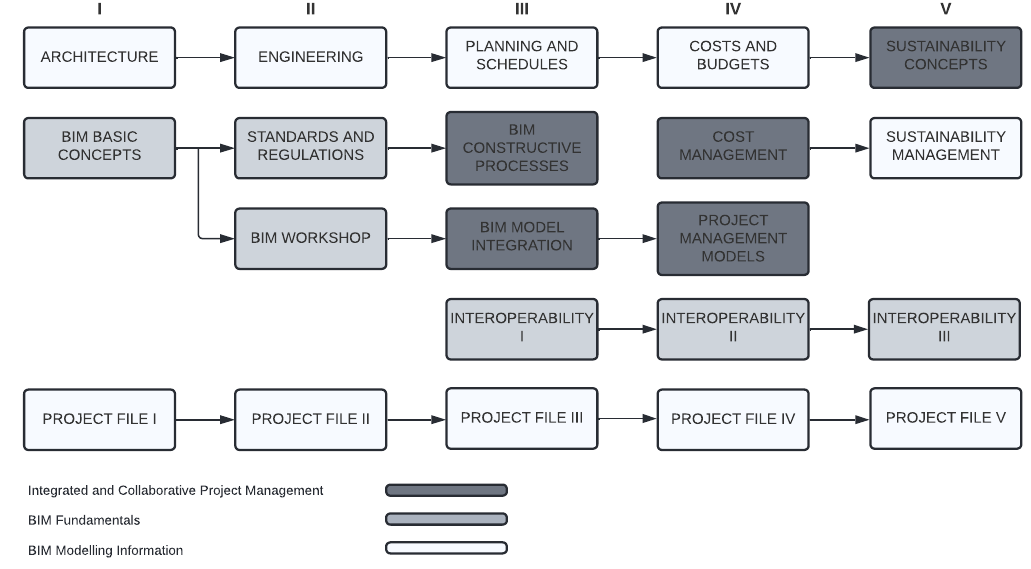
Figure 1. BIM curriculum with subjects and prerequisites.